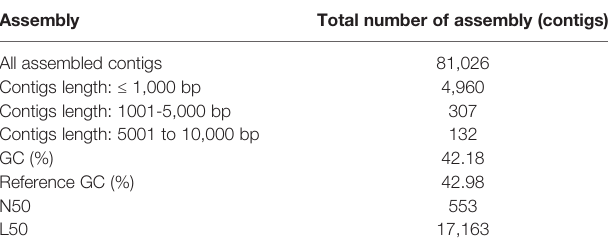
TABLE 3 | Statistics of the assembled contigs from NGS sequence analysis.